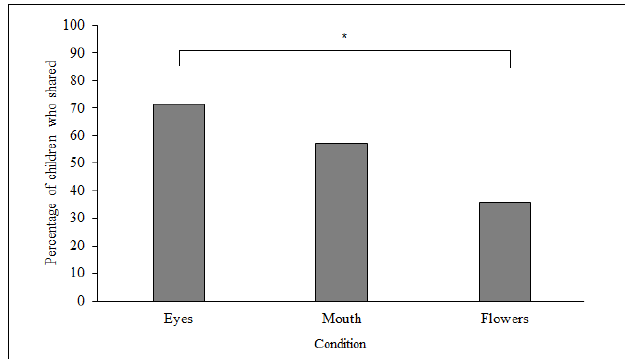
FIGURE 2 | The percentages of 3-year-olds in the explicit “watching eyes” paradigm who shared. Note: ∗ p <